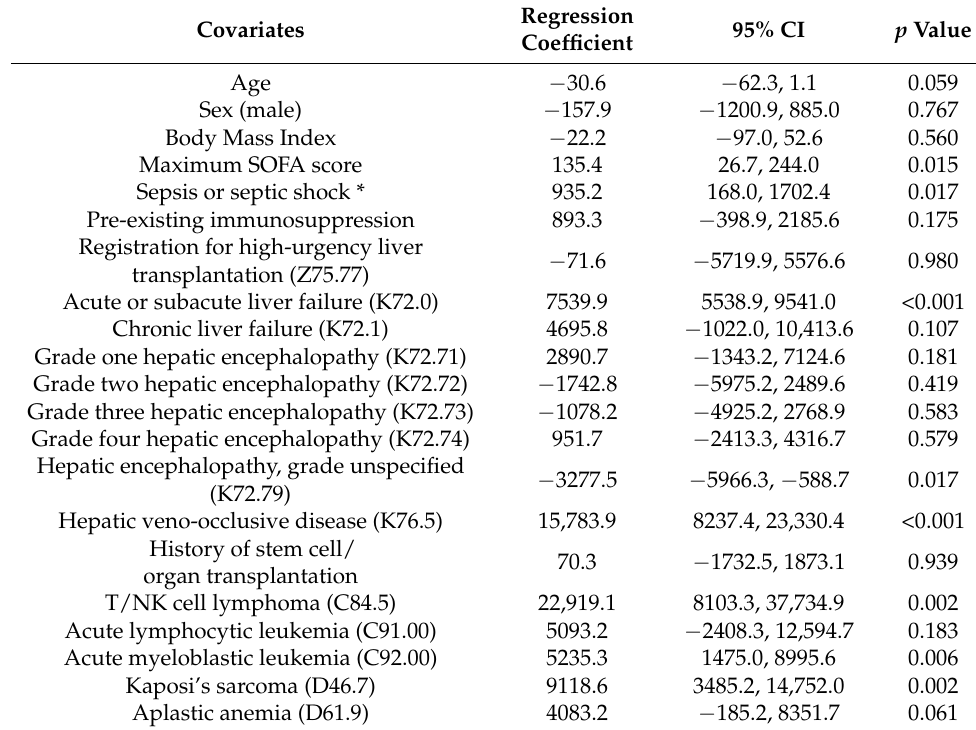
Table 3. Multivariable linear regression analysis for the influence of subgroups of liver disease and hematological malignancy on maximum